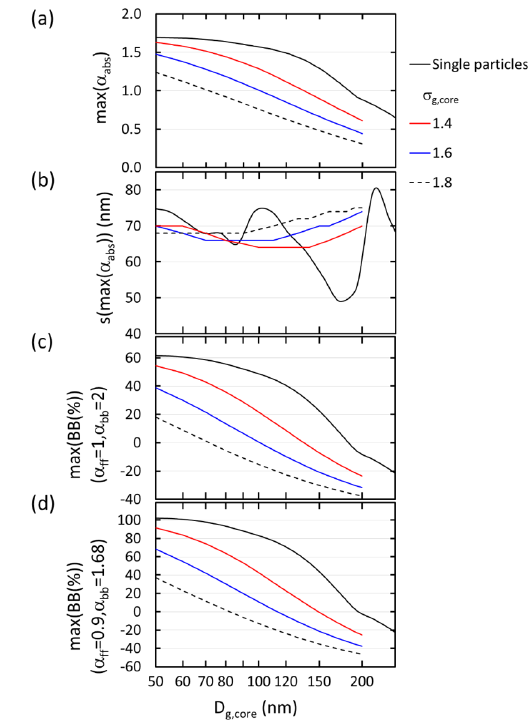
Figure 4. Size distribution dependence of the first maximum of α abs when a size-independent shell grows on a BC core: (a) the first maximum value of α abs , (b) the shell thickness at the maximum α abs , (c) maximum biomass-burning fraction with the Aethalometer model constants α ff = 1 and α bb = 2, and (d) maximum biomass- burning fraction with the Aethalometer model constants α ff = 0.9 and α bb = 1.68 as a function of the BC core geometric mean diam- eter ( D g , core ) and geometric standard deviation ( σ g , core